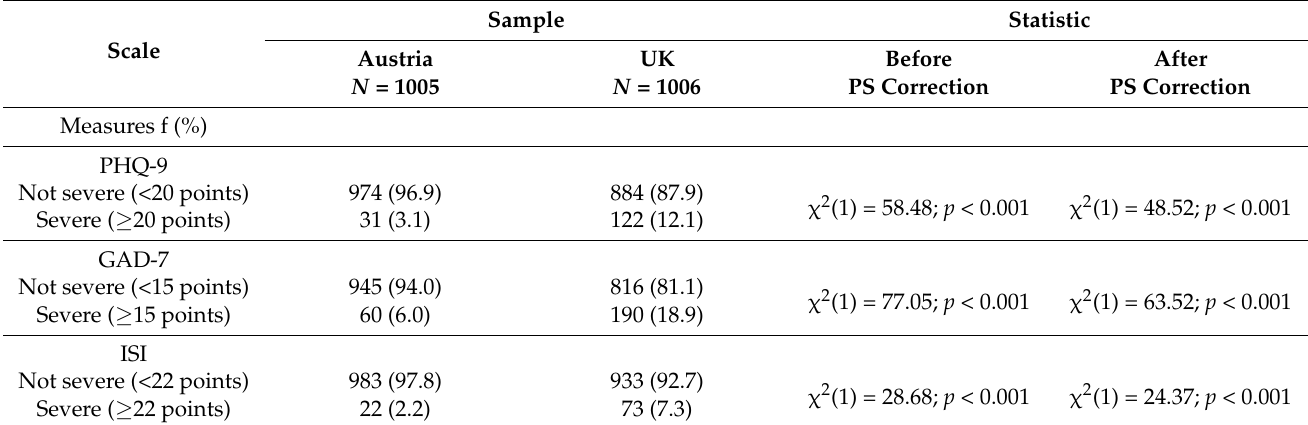
Table 1. Differences in severe symptoms of depression, anxiety, and insomnia between Austria and the UK after 4 weeks of COVID-19 lockdown. Sample Scale